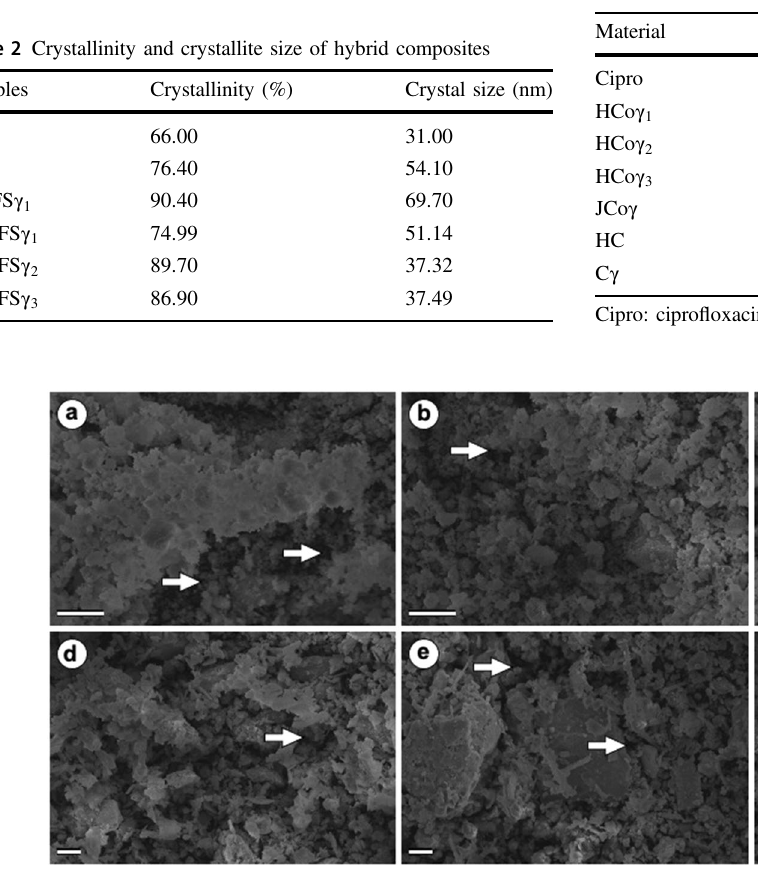
Fig. 2 Photomicrographs of scanning electron microscopy of biomaterials. Bars: 20 µm. a HCoFS γ 1 (70:30) ( b ) HCoFS γ 2 (50:50); ( c ) HCoFS γ 3 (30:70); ( d ) JCoFS γ (70:30); ( e ) C γ ; and ( f ) HC (70:30). The arrows highlight the pores